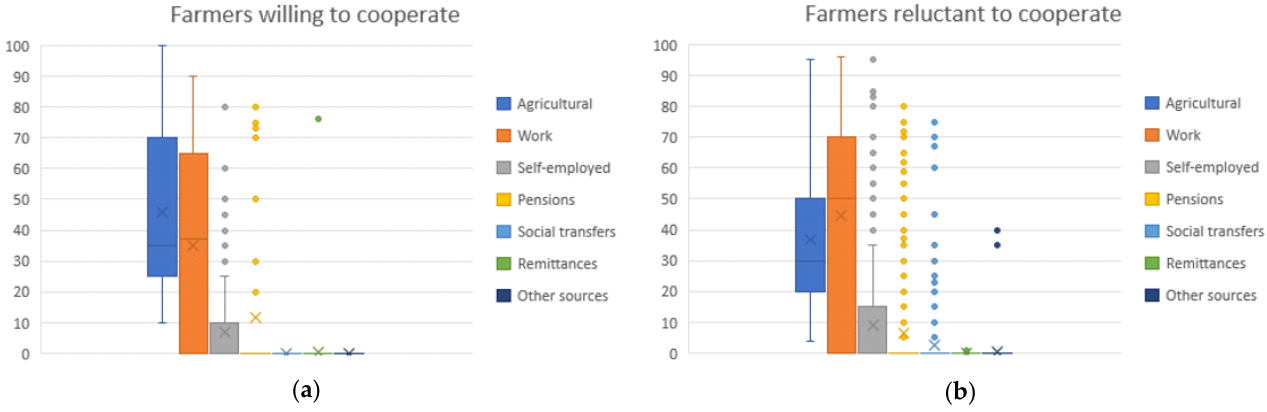
Figure 9. Farming types of the groups of small-scale farms willing to cooperate ( a ) and reluctant to cooperate ( b ) (N = 1002).